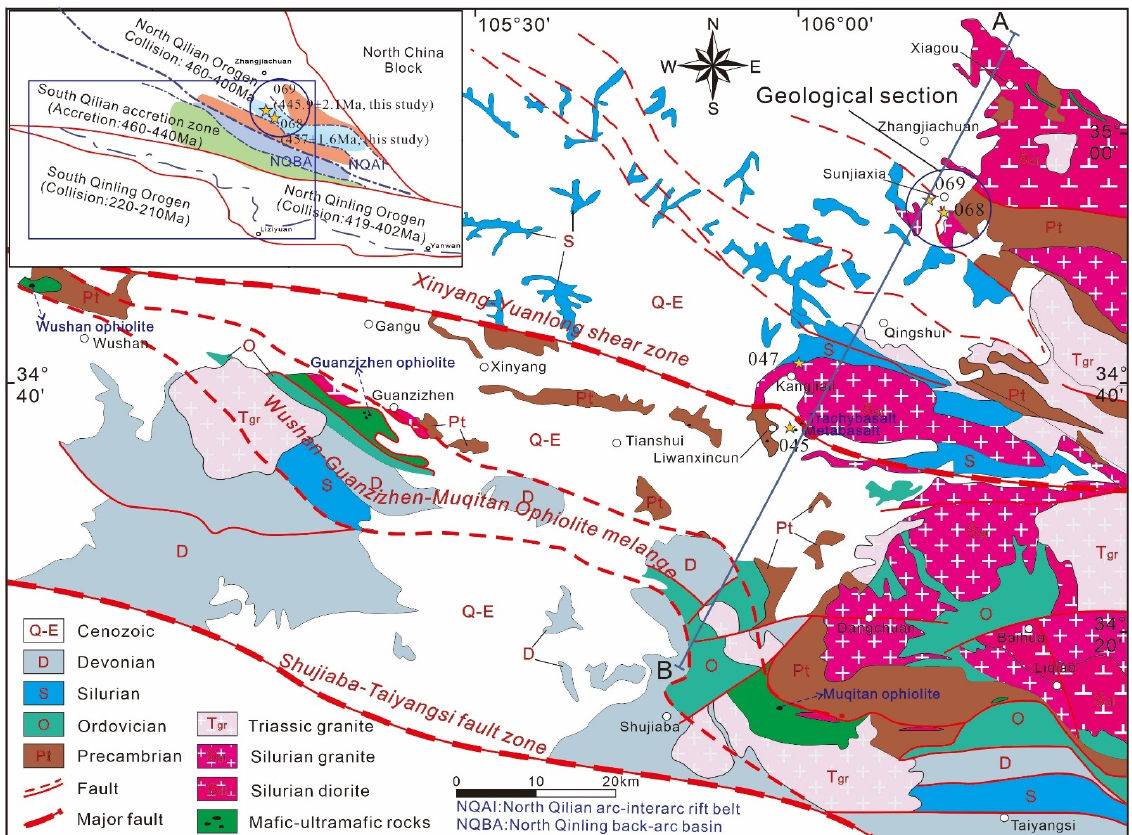
Figure 2. Simplified geological map of the Tianshui-Sunjiaxia area; modified after Pei et al. (2009) [16]. The blue line shows the geological section across the connection zone between the North Qilian Orogen and the West Qinling Orogen.